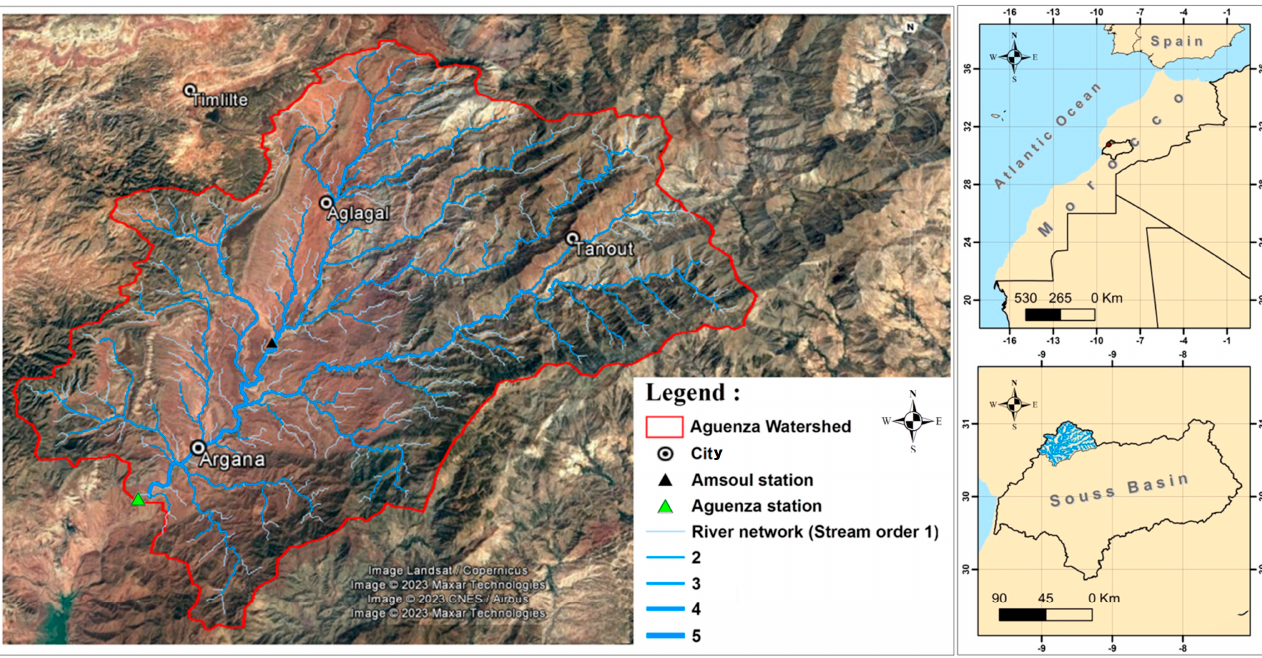
Figure 1. Location of the Aguenza watershed, Morocco.